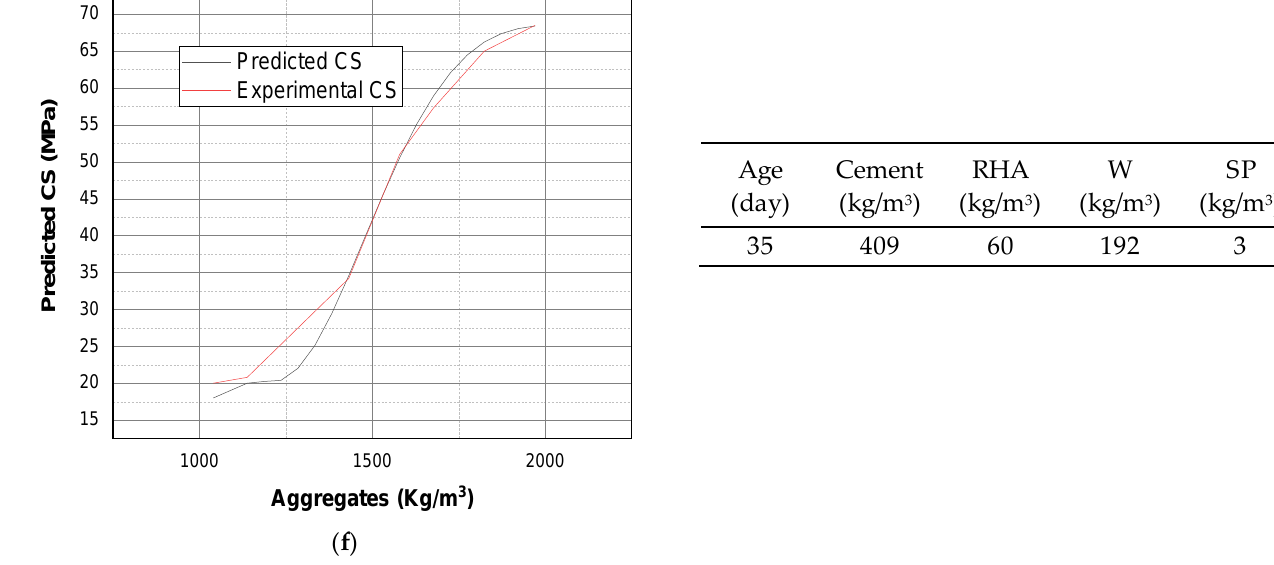
Figure 11. Parametric analysis of inputs. ( a ) Age, ( b ) cement, ( c ) RHA, ( d ) water content, ( e ) superplasticizer, ( f ) ag- gregates .